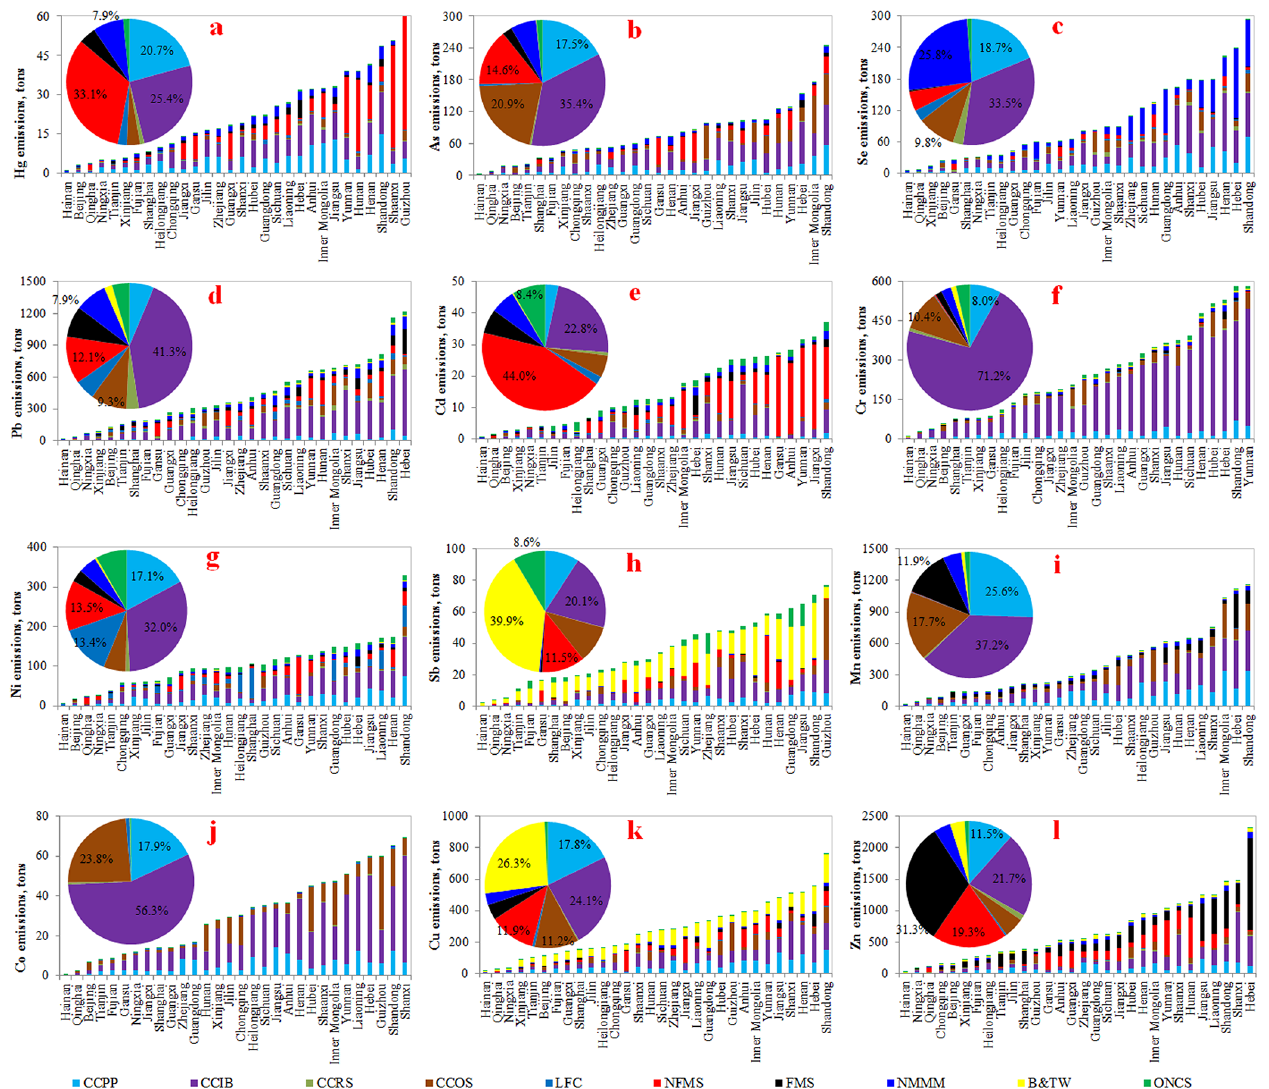
Figure 4. Provincial HM emissions from anthropogenic sources and national composition by source categories in 2010.